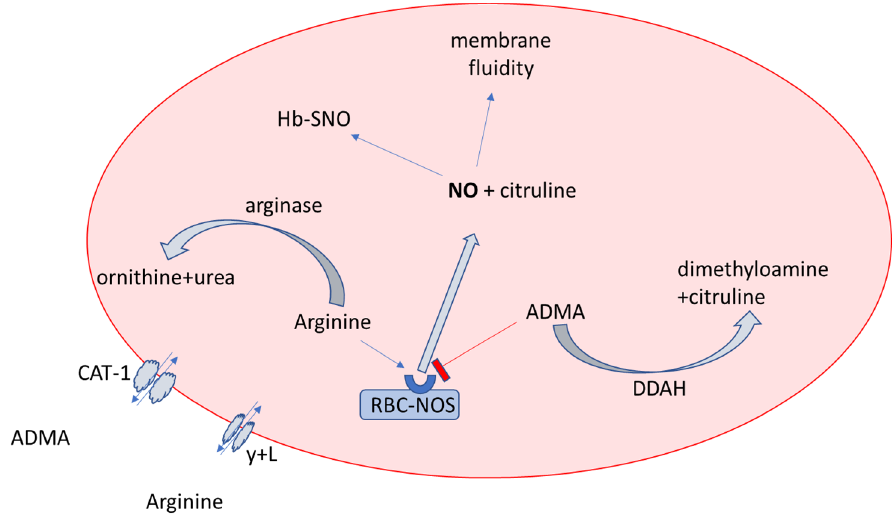
Figure 8. Nitric oxide bioavailability in erythrocytes. Abbreviations: NO: nitric oxide; RBC-NOS: nitric oxide synthase; ADMA: asymmetric dimethylarginine; CAT-1: cationic amino acid transporter-1; HB-SNO: S-nitrosohemoglobin; DDAH: dimethylarginine dimethylaminohydrolase; y + L: amino acid trans- porter.